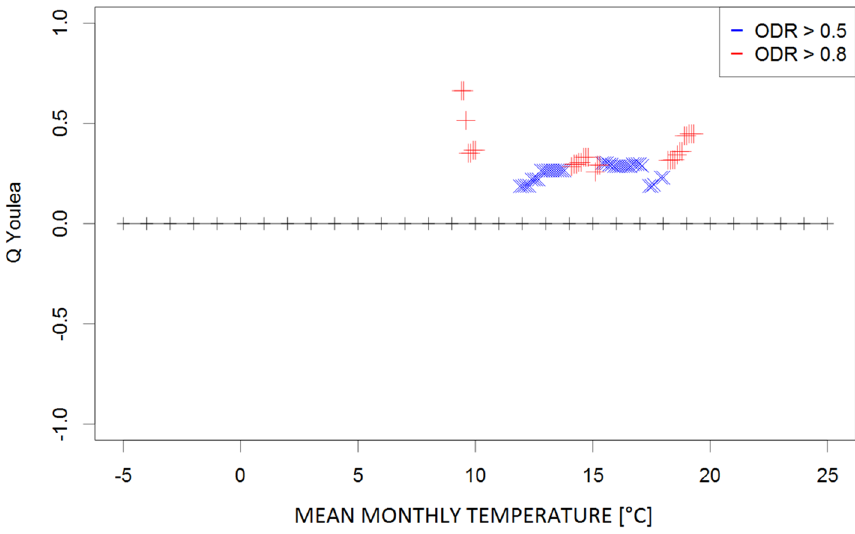
Figure 1. Plot of Q coefficients for different threshold levels of mean monthly temperature (Ta) for the investigated ODR limits (≥ 0.5 and ≥ 0.8).